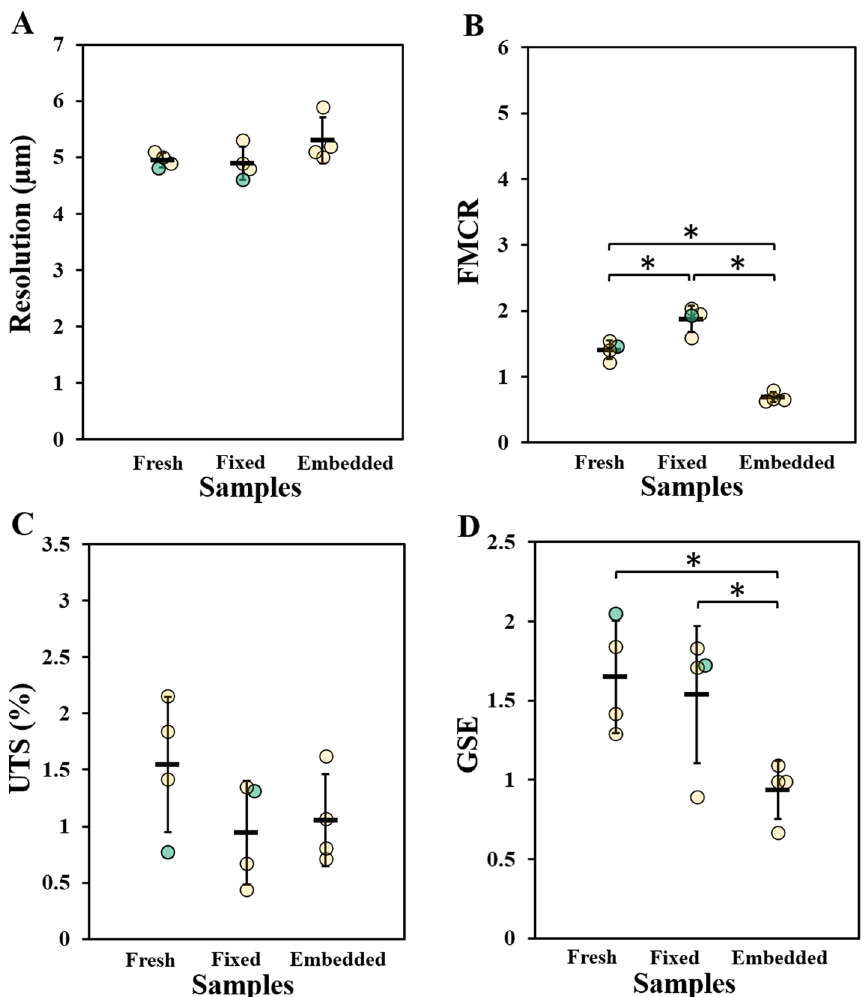
Figure 6. The image quality for different sample preparations. The quality of images acquired by HNAM was evaluated as: ( A ) spatial resolution, ( B ) fiber to matrix contrast ratio (FMCR), ( C ) uncertainty of the threshold-based segmentation (UTS), ( D ) magnitude gradient sharpness at the edges (GSE). Individual sample measurements are shown as circles, mean and standard deviation for each group are indicated. Fresh = fresh frozen samples in PBS, fixed = fixed samples in ethanol, embedded = fixed samples embedded in paraffin; samples that were also imaged with HRM are highlighted in